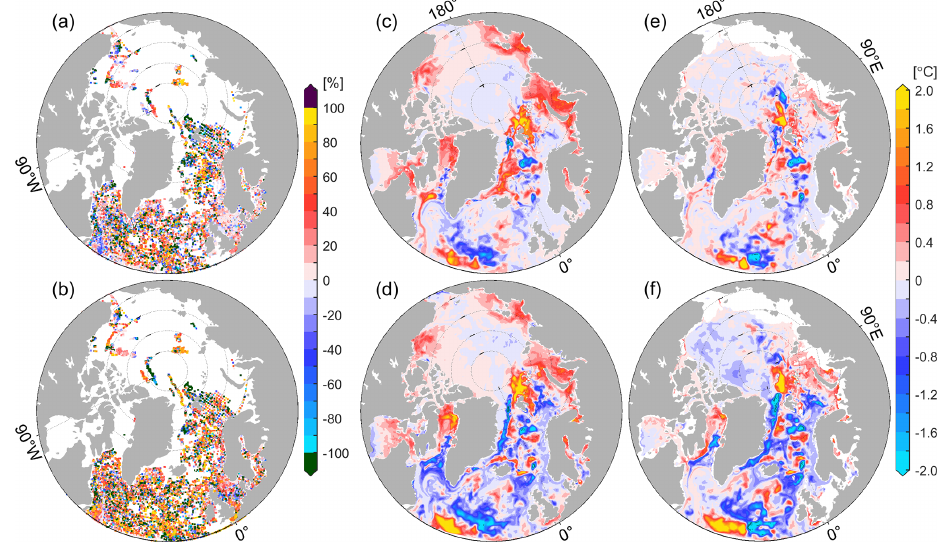
(cid:12) (cid:12) (cid:12) T opti − T obs (cid:12) −| T ctrl − T obs | × 100%) over the top 50m at the profile locations in (a) adjoint- | T ctrl − T obs |